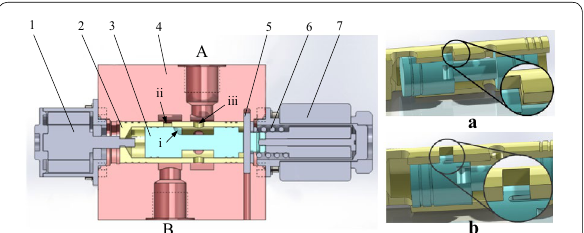
Figure 13 2-DOF fault tolerant electro-hydraulic directional control valve: a rotary failure state of valve sleeve; b movement failure state of spool. 1. Rotary motor; 2. Valve sleeve; 3. Spool; 4. Valve body; 5. Pin; 6. Compression spring; 7. Linear motor; i. Valve groove; ii, iii. Valve sleeve